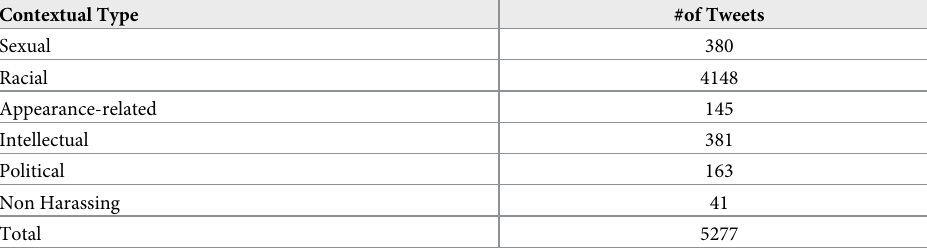
Table 4. Statistics for the Golbeck corpus after our annotation wrt. contextual